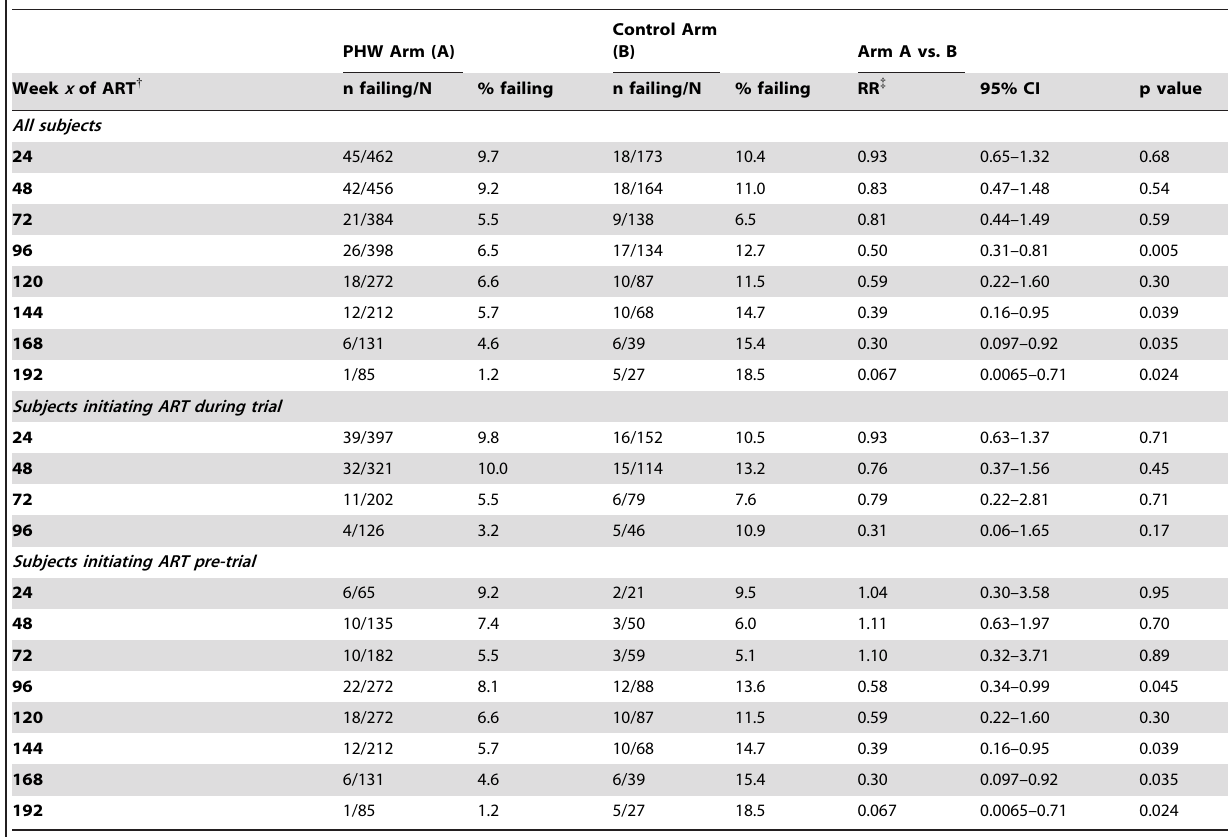
Table 2. Estimates of effect for virologic outcomes.*